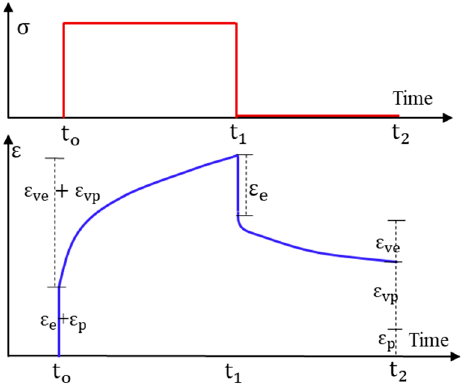
Figure 4. Stress–strain state in compression: ( a ) hysteresis loop under creep-recovery and ( b ) cross- head strain rate test.